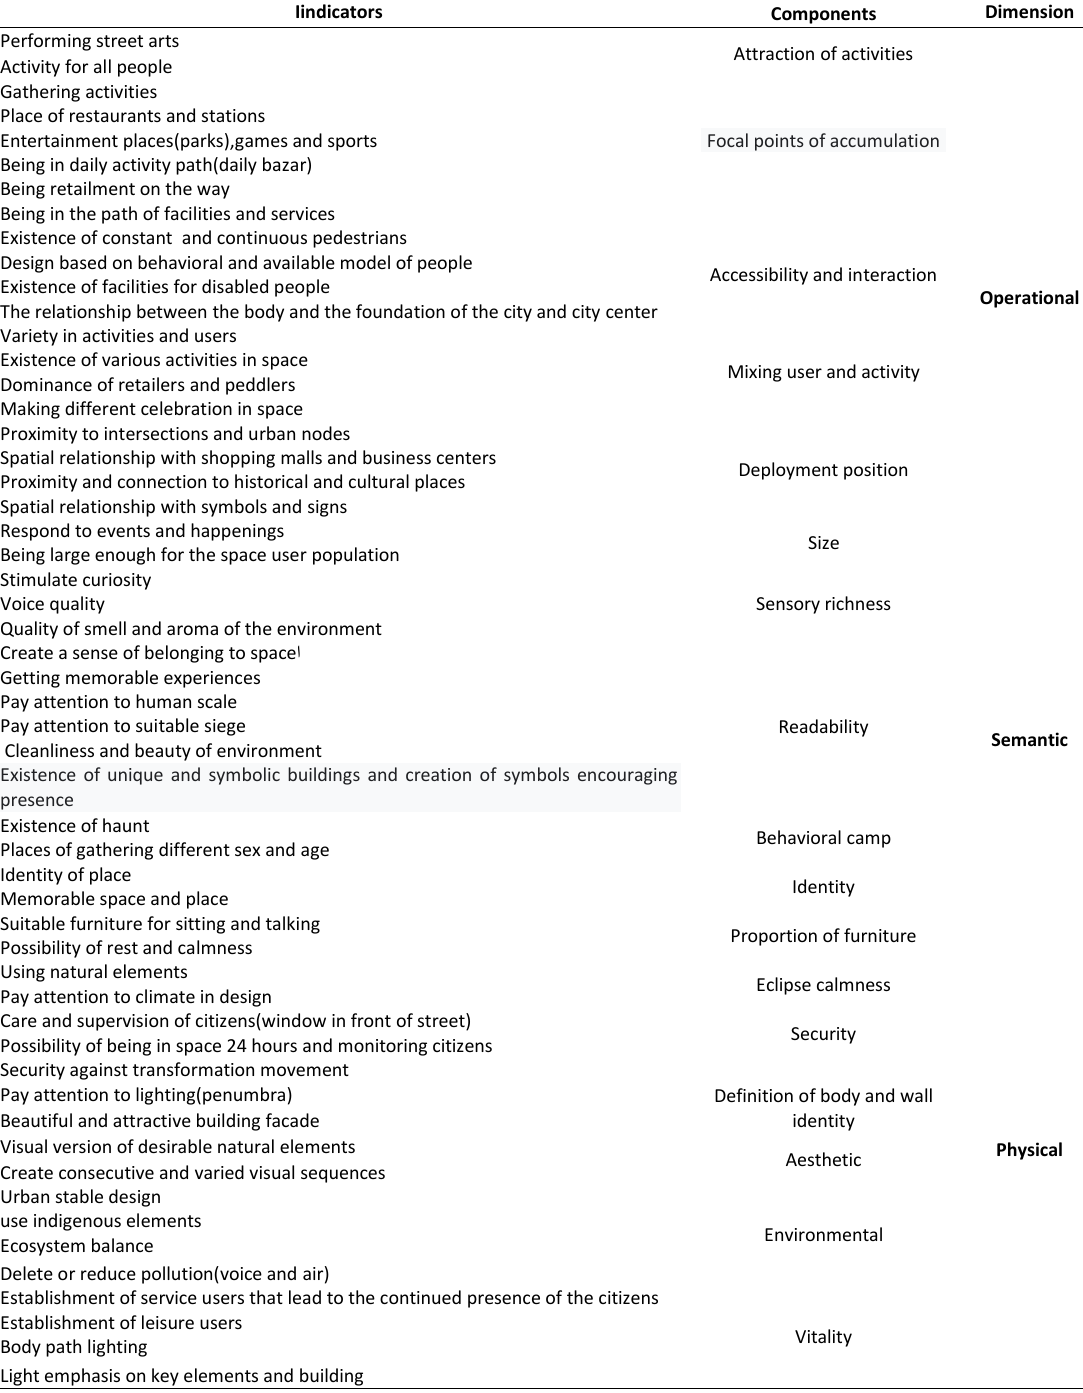
Table 10: Extracted indicators